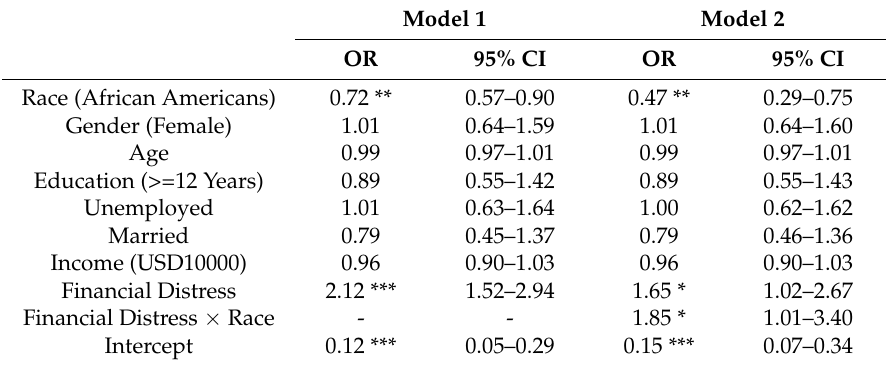
Table A1. Summary of logistic regressions with financial distress as the independent variable and MDE as the dependent